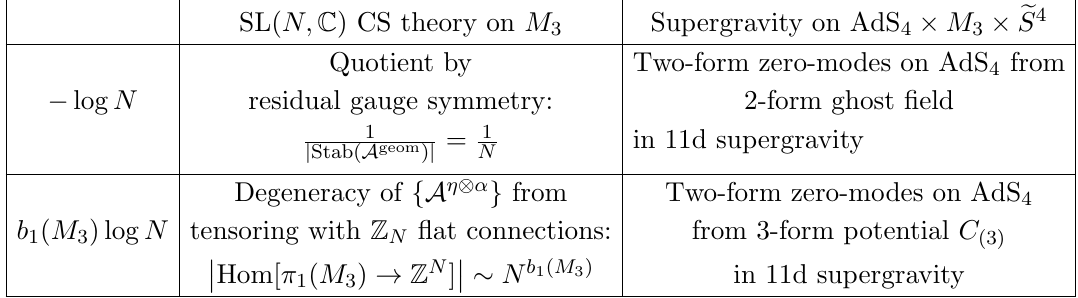
Table 1 . Comparison between the origin of logarithmic corrections to the superconformal index of T N [ M 3 ], from the 3d-3d dual SL( N; C ) Chern-Simons theory and from the holographic supergravity. Here L is the radius of AdS and G is the 4d Newton constant. We used the relation 4 (4)